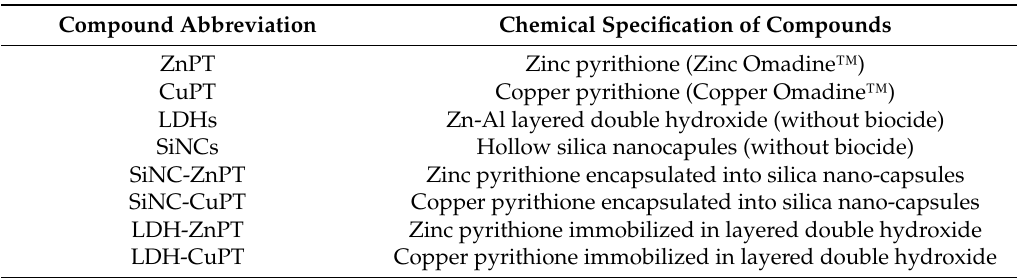
Table 1. Tested compounds and their chemical